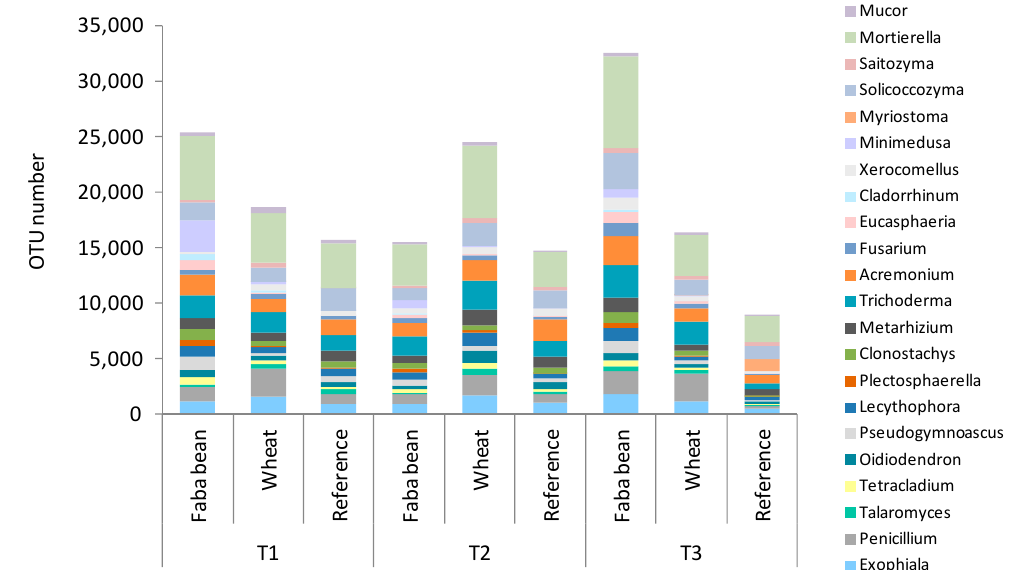
Figure 3. Number of operational taxonomic units (OTUs) of the dominant fungal genera, as affected by forecrop. OTUs less than 2% were not analyzed. T1, T2, and T3 denote: two months after residue incorporation into the soil, stem elongation, and the senescence stage of the subsequent wheat crop, respectively.